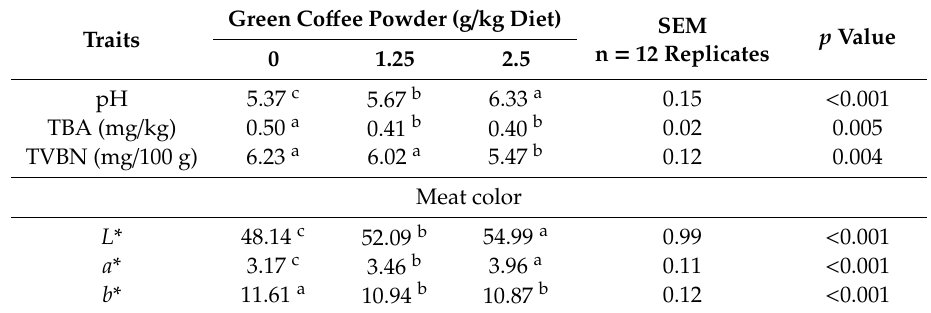
Table 6. Mean values of pH, and TBA (mg / kg), TVN (mg / 100 g) and color in the examined samples treated with di ff erent levels of green co ff ee powder.